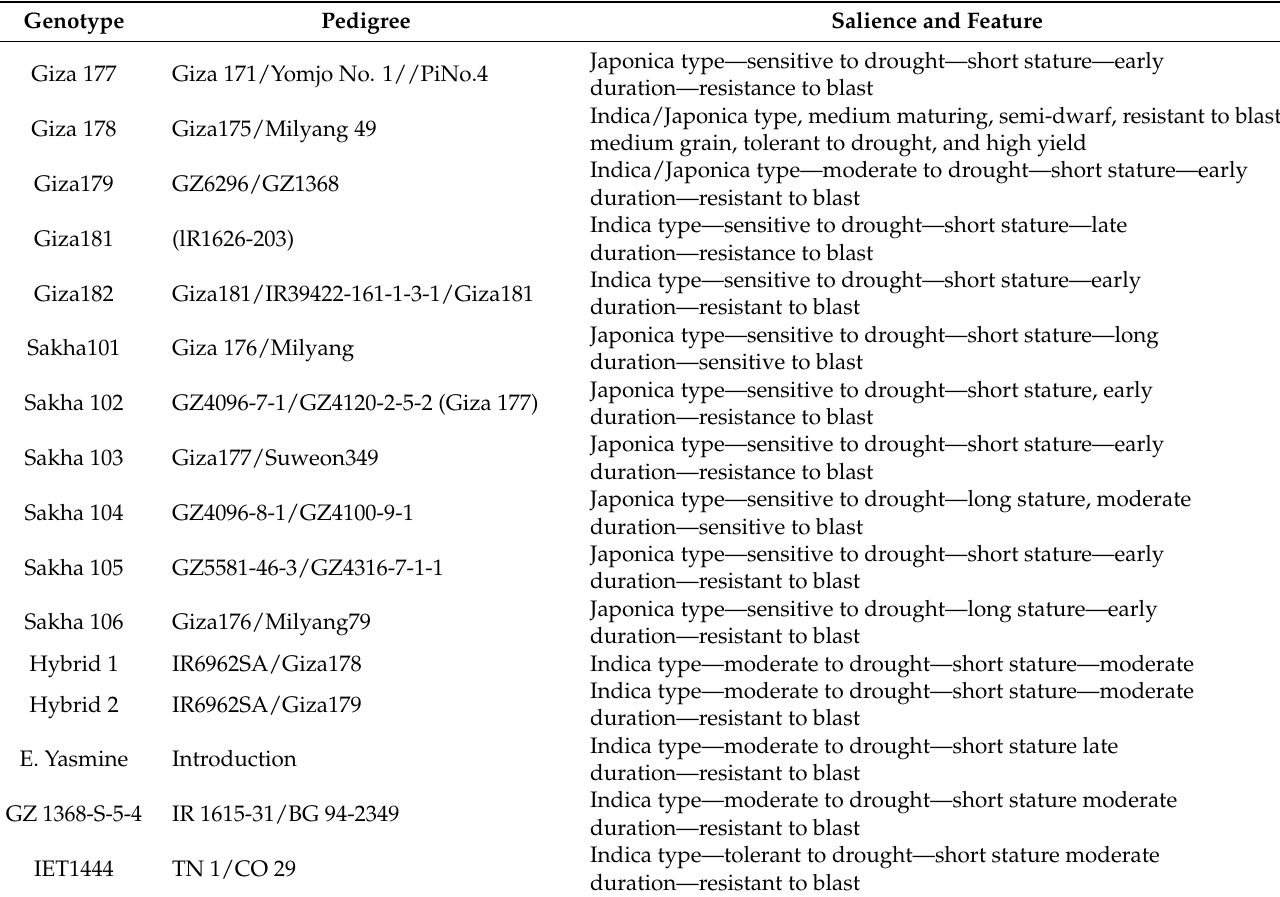
Table 2. Origin, pedigree, salience, and feature of sixteen rice